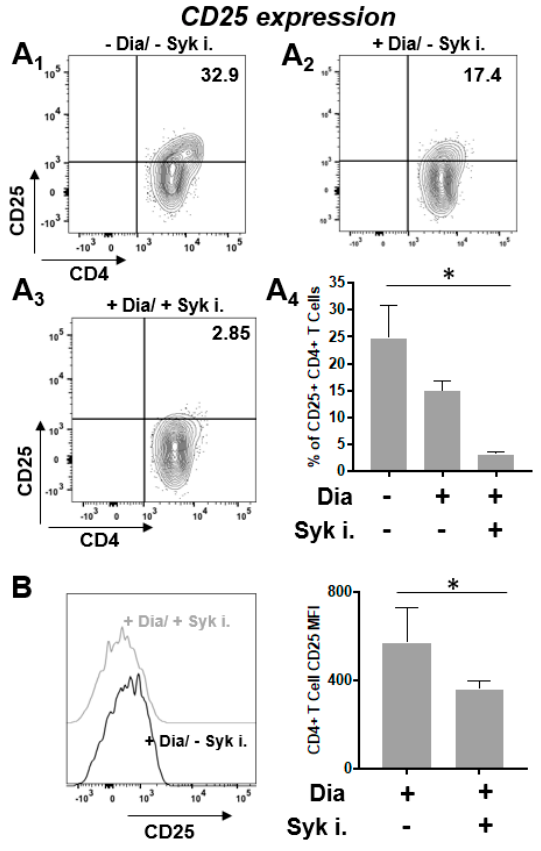
Figure 6. Expression of T cells CD25 receptor after treatment with diamide and Syk inhibitors. Cells exposed to 0.3 mM diamide with/out 5 μ M Syk inhibitors (Syk i) at 60 minutes incubation time. Samples were incubated surface-CD25 and analyzed by Flow cytometry (N = 3). ( A1 ) Anti-human CD25 flow representative density plot of untreated cells. ( A2 ) Anti-human CD25 flow representative density plot of T cells exposed to 0.3 mM diamide. ( A3 ) Anti-human CD25 flow representative density plot of T cells exposed to 0.3 mM diamide and incubated with Syk inhibitor. Medians are showed. p values which were statistically significant are shown (* p < 0.05). Values are plotted as mean ± error standard ( A4 ). Data are the percentage of total cell population (%). ( B ) Samples were incubated with human surface anti-CD25 and analyzed by Flow cytometry. Comparison of MFIs between diamide- treated T cell samples in presence versus absence of Syk inhibitors incubation.